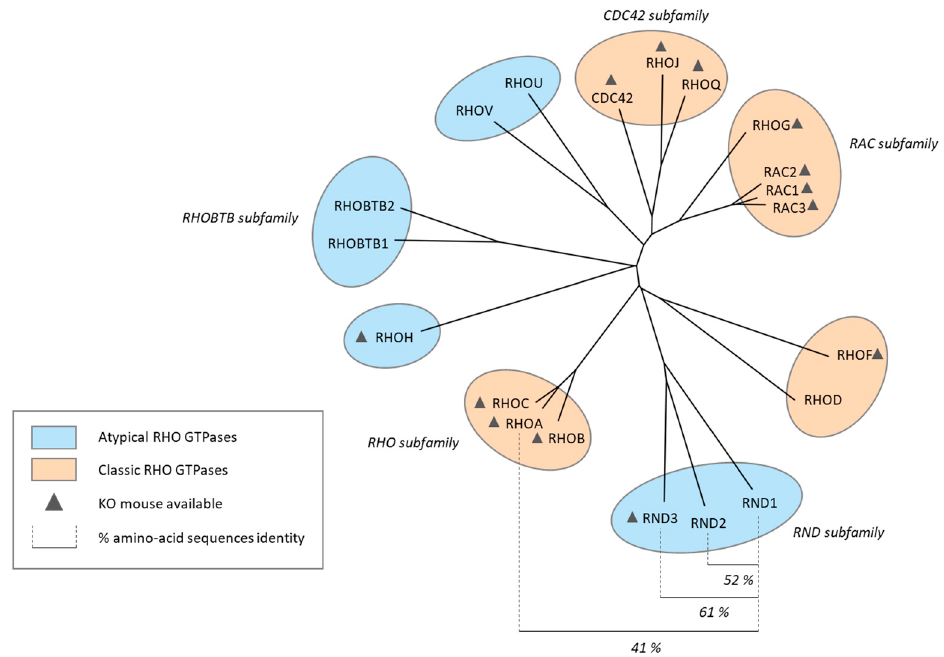
Figure 1. Rho GTPase family. The phylogenetic tree of the Rho GTPase family was obtained from the alignment of the amino-acid sequences of the 20 Rho GTPases using the Clustal Omega program. The tree was generated using the iTOL software. Rho members are structured into eight subfamilies, including the Rho subfamily (RHOA, RHOB, and RHOC), the RAC subfamily (RAC1, RAC2, RAC3, and RHOG), the CDC42 subfamily (CDC42, RHOQ and RHOJ), the RND subfamily (RND1, RND2 and RND3), the RHOU/V family (RHOU and RHOV), the RHOD/F subfamily (RHOD and RHOF), the RHOBTB subfamily (RHOBTB1 and RHOBTB2) and RHOH. Classic Rho GTPases comprise the RHO, RAC, CDC42, and RHOD / F subfamilies. Atypical Rho GTPases include the RND, RHOU / V, RHOBTB, and RHOH subfamilies. Rho GTPases, which have a knockout (KO) mouse model, are annotated with a triangle. Percentage of amino-acid-sequences identity between RND1 and other Rho GTPases members were determined with the Clustal Omega tool.